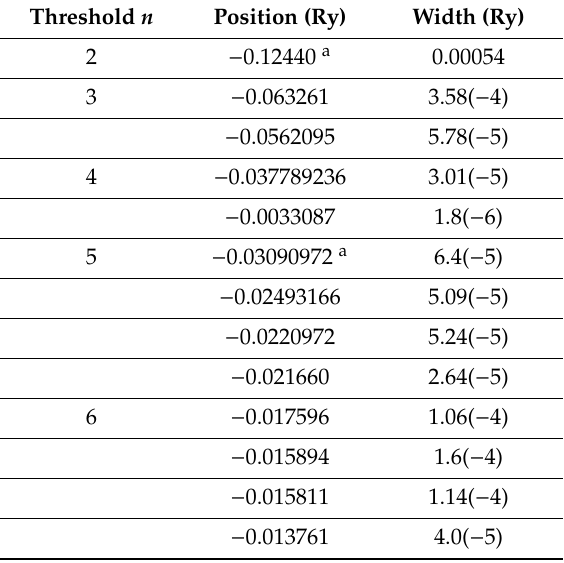
Table 19. Doubly-excited or Feshbach-type 3 P e resonances in Ps − .